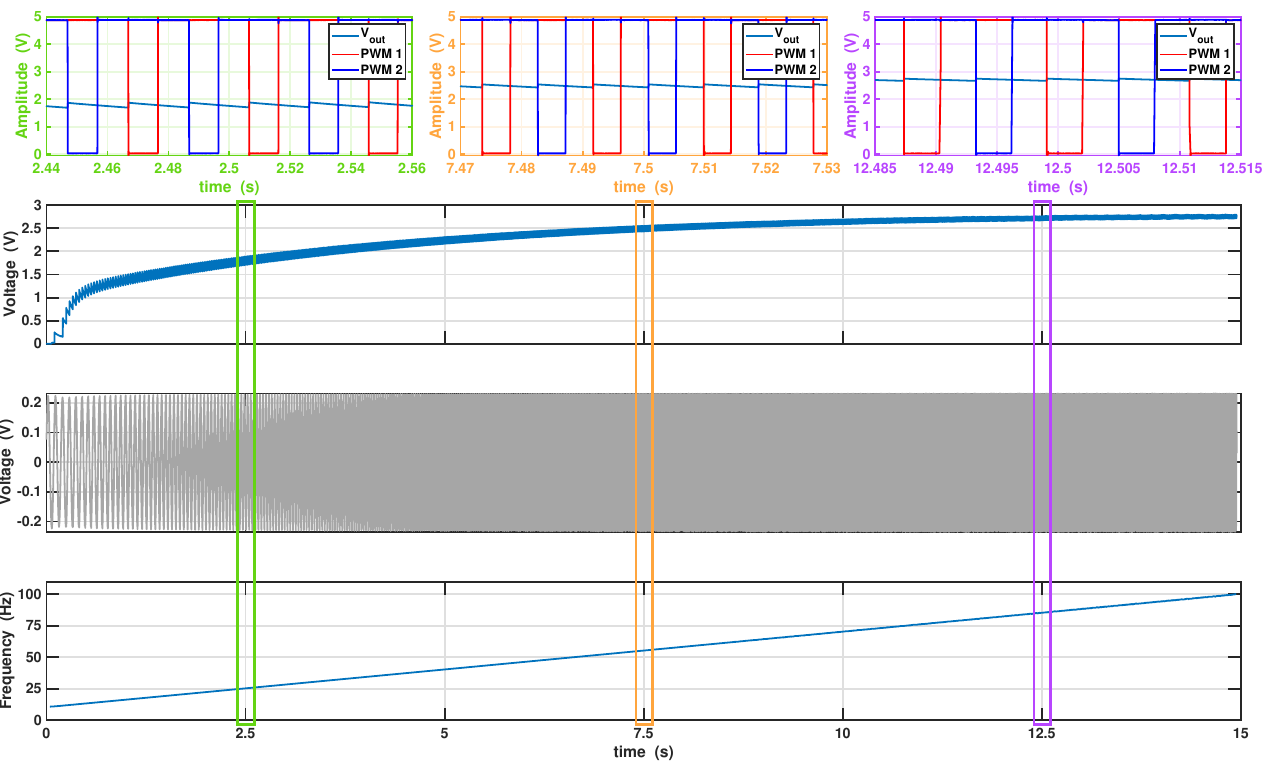
Figure 12. Ripple Factor (RF) values with respect to Duty Cycle (D) and Time Delay (T D ) at different input voltage frequencies (f in ). The insets show the top view of each surfaces, while red dots identify the maximum values.